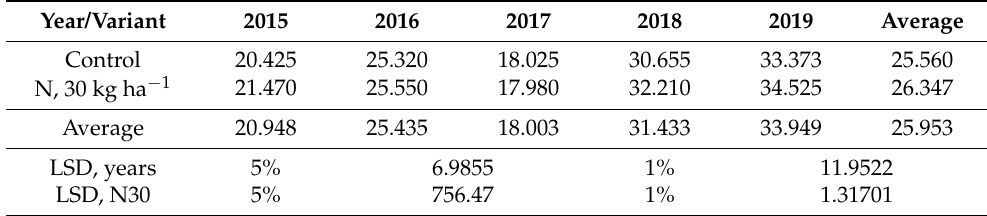
Table 5. Dry stalk yield (kg ha − 1 ) during 2015–2019.